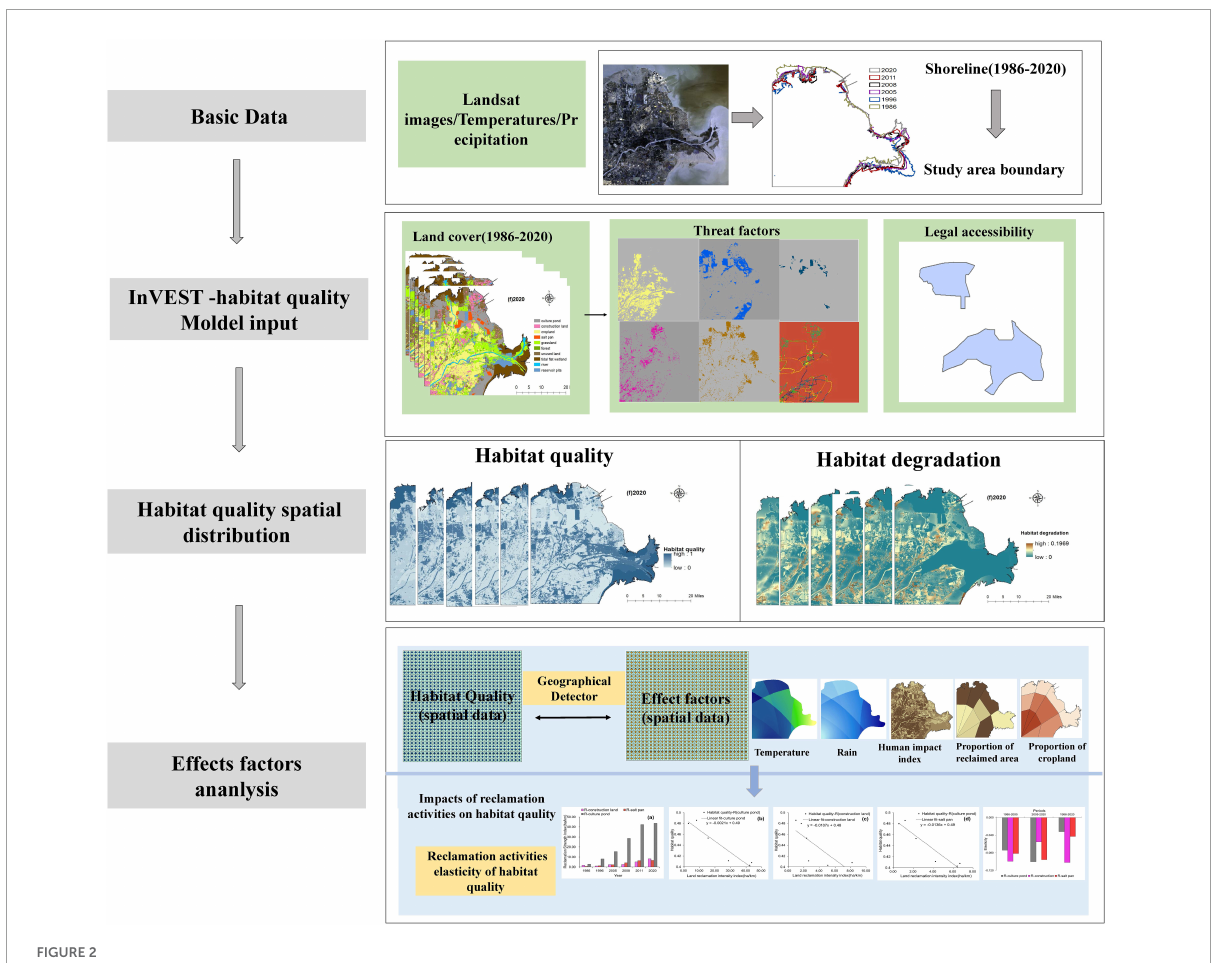
FIGURE2 Flowchart showing methodological steps followed in the study.